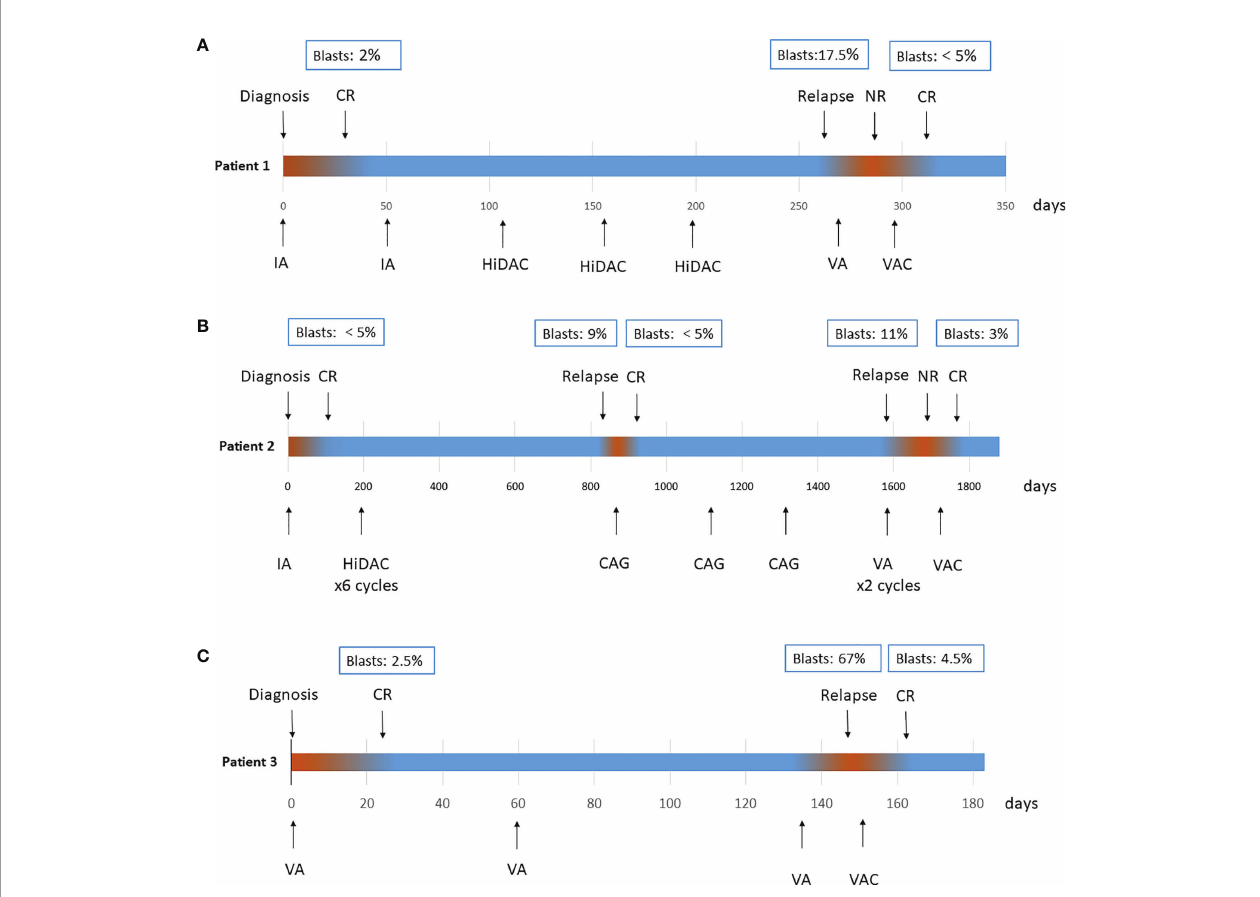
FIGURE 1 | Treatment process of patient 1 (A) , patient 2 (B) and patient 3 (C) . CR, complete remission; IA, cytarabine 100 mg/m 2 continuous infusion day1 – 7, idarubicin 12 mg/m 2 day1 – 3; HiDAC, cytarabine 2 g/m 2 over 3 h every 12 h on day1 – 3; CAG, cytarabine 10 mg/m 2 every 12 h, day1 – 14; aclarubicin 5 – 7 mg/m 2 , daily on day1 – 8; and concurrent use of G-CSF 200 µg/m 2 /day; VA, venetoclax once daily (100 mg day1, 200 mg day2, 400 mg day3 – 28) and azacitidine 75 mg/m 2 day1 – 7; VAC, venetoclax once daily (100 mg day1, 200 mg day2, 400 mg day3 – 21), azacitidine 75 mg/m 2 daily day1 – 7, chidamide 5 mg daily day1 –